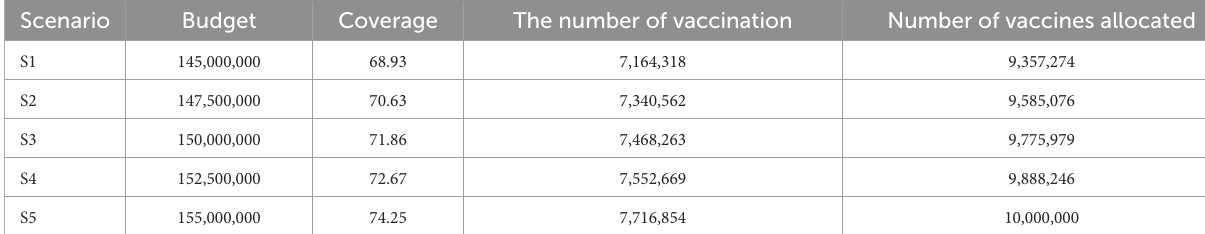
TABLE 10 Sensitivity analysis of budget